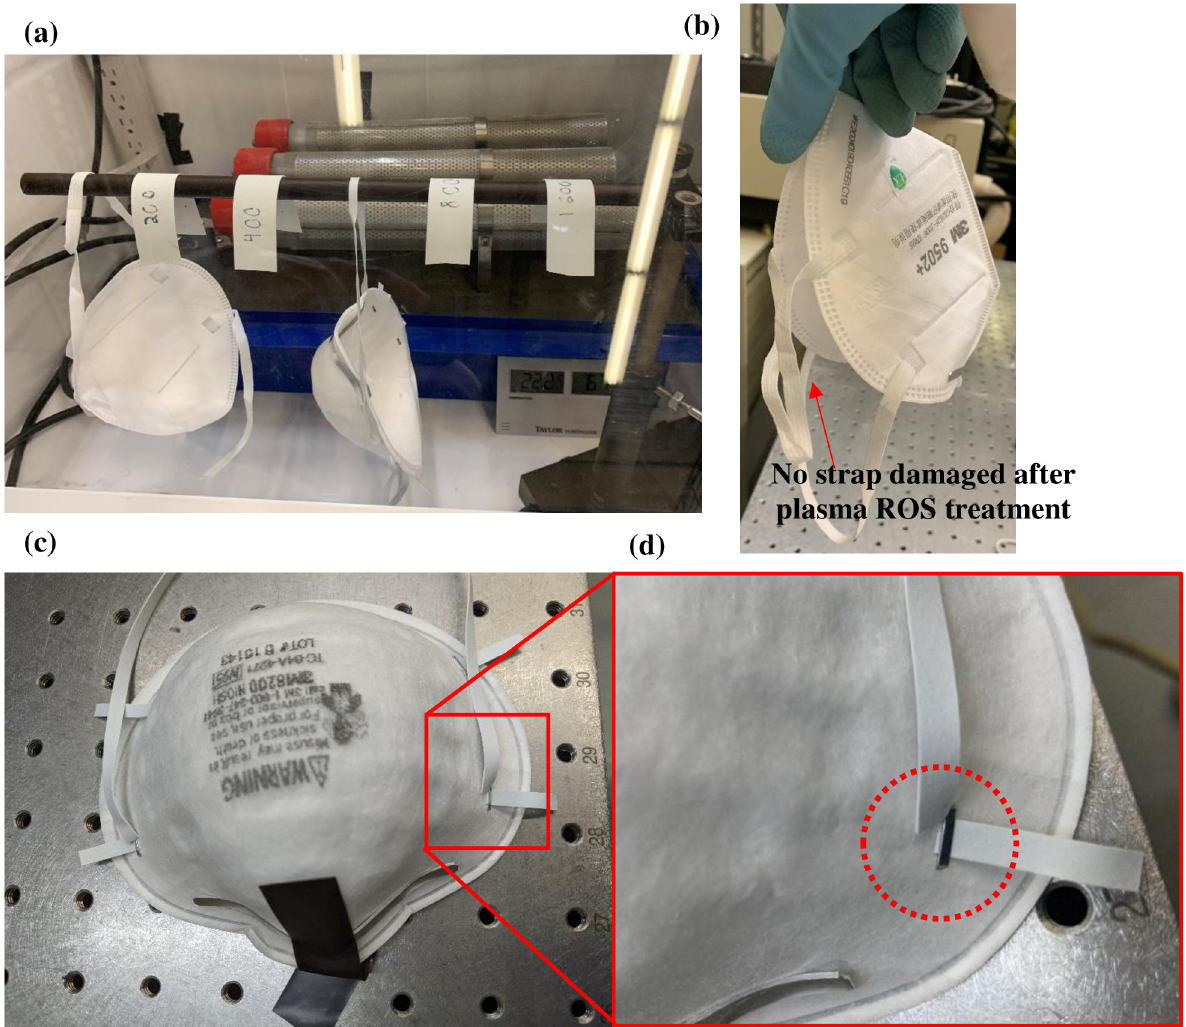
Fig 23. (a) Respirators during glovebox testing after treatment to 1600 ppm-min ozone exposure. (b) 3M 9502+ and (c) 3M 8200. (d) A zoomed-in view of the damaged 3M 8200 respirator straps after treated at 1600 ppm-min ozone